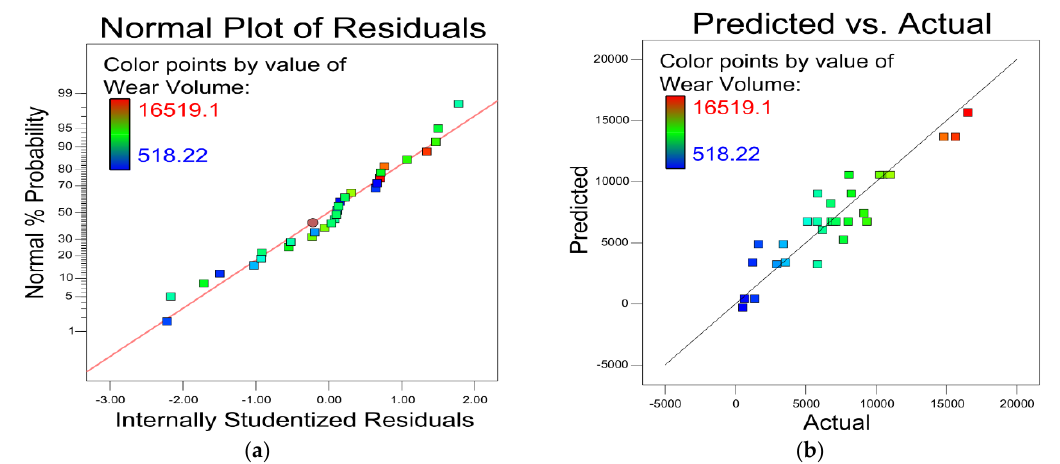
Figure 9. ( a ) Residual analysis on wear volume. ( b ) Comparison of predicted and actual wear volume.